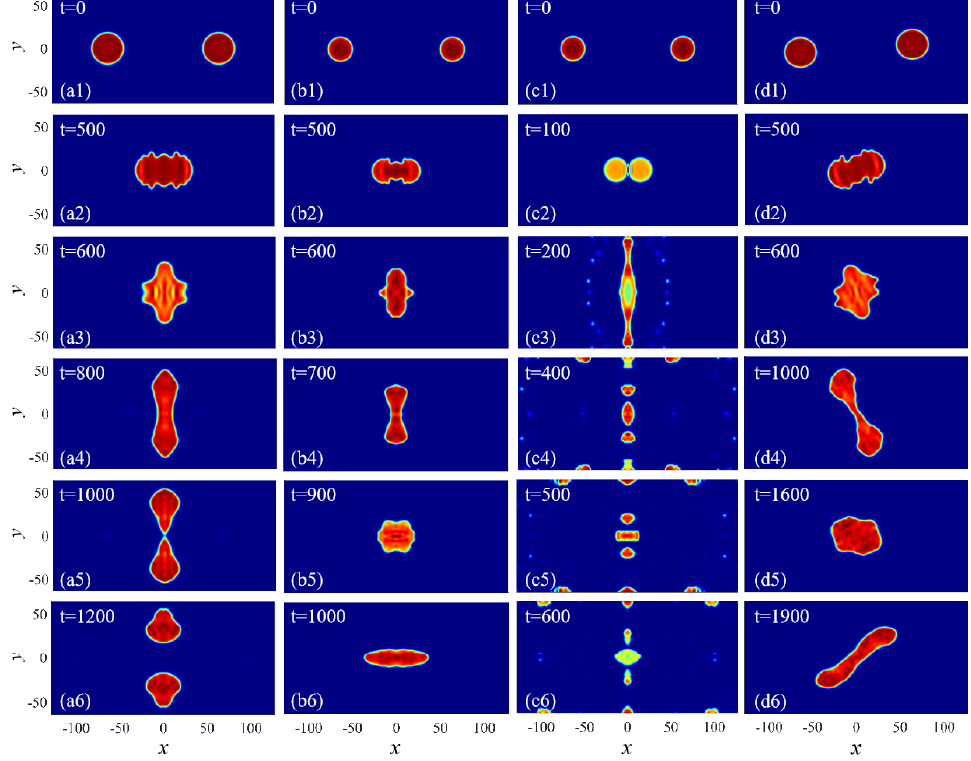
Figure 4. Several typical examples of colliding QDs. ( a – c ) The collision of two QDs by inputting Equation (17) with x 0 = 64 and the norm of each QD N = 500. ( a1 – a6 ) Quasi-elastic collisions between two QDs with κ = 0.05 and η = 0.1. ( b1 – b6 ) Completely inelastic collisions between two QDs with κ = − 0.05 and η = 0.1. ( c1 – c6 ) Collisions between two QDs with κ = − 0.05 and η = 0.5. ( d1 – d6 ) The off-center collision of two QDs by input Equation (18) with x 0 = 64 and y 0 = 10; the other parameters are κ = 0.05 and η =